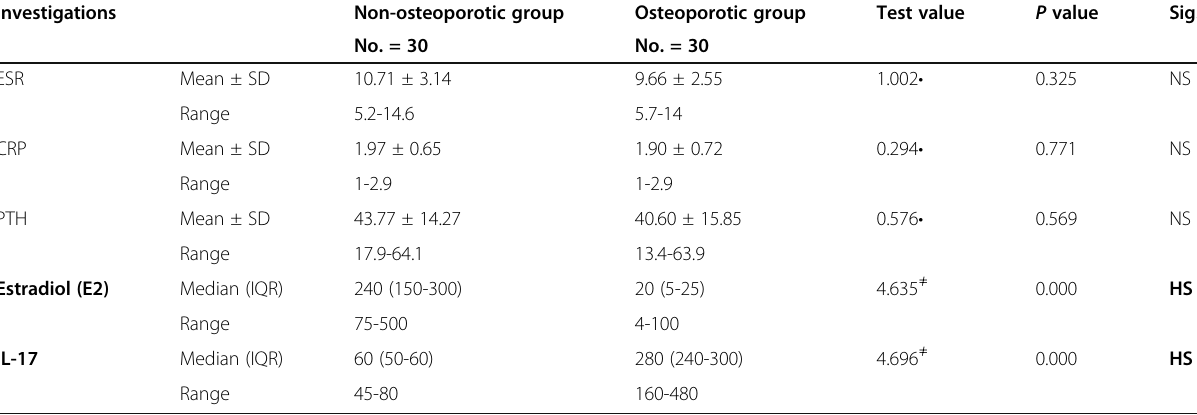
Table 3 Comparative statistics between the 2 groups regarding laboratory data